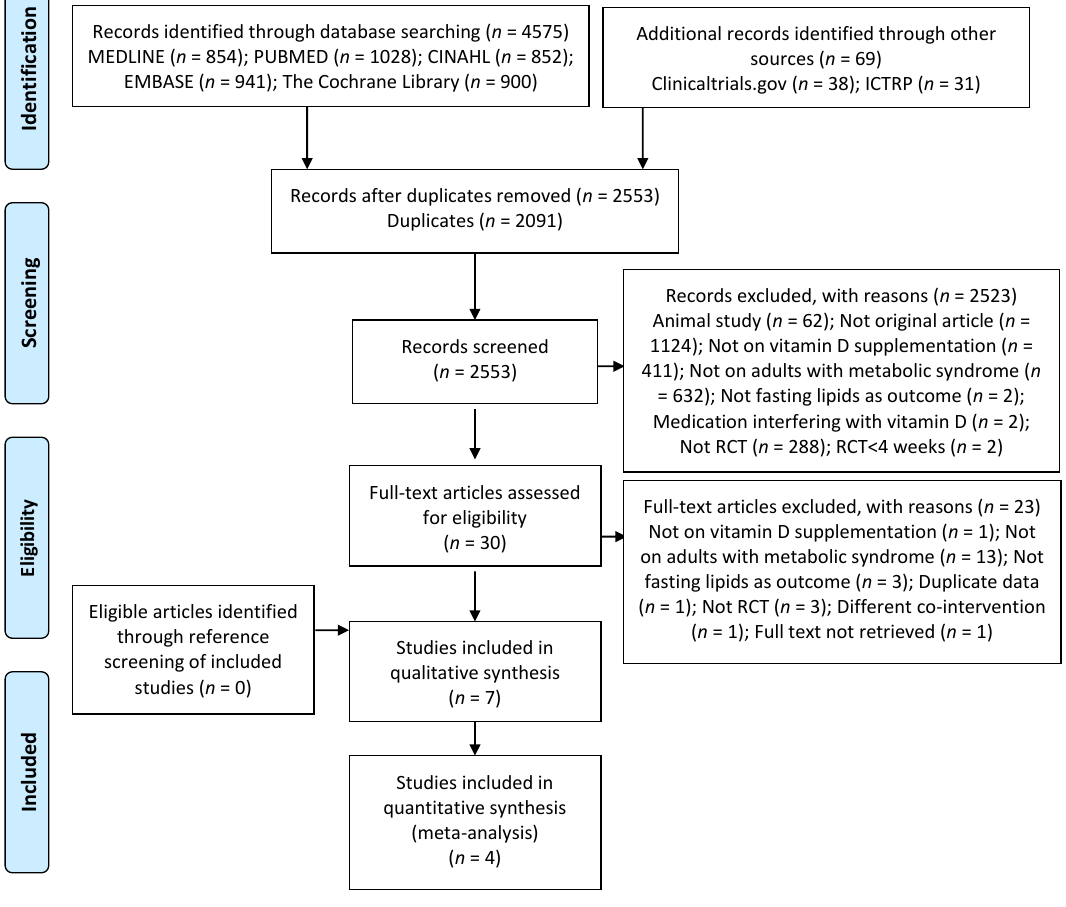
Figure 1. Preferred Reporting Items for Systematic Reviews and Meta-Analyses (PRISMA) diagram of study selection. ICTRP: International Clinical Trials Registry Platform; RCT: Randomized Controlled Trial.